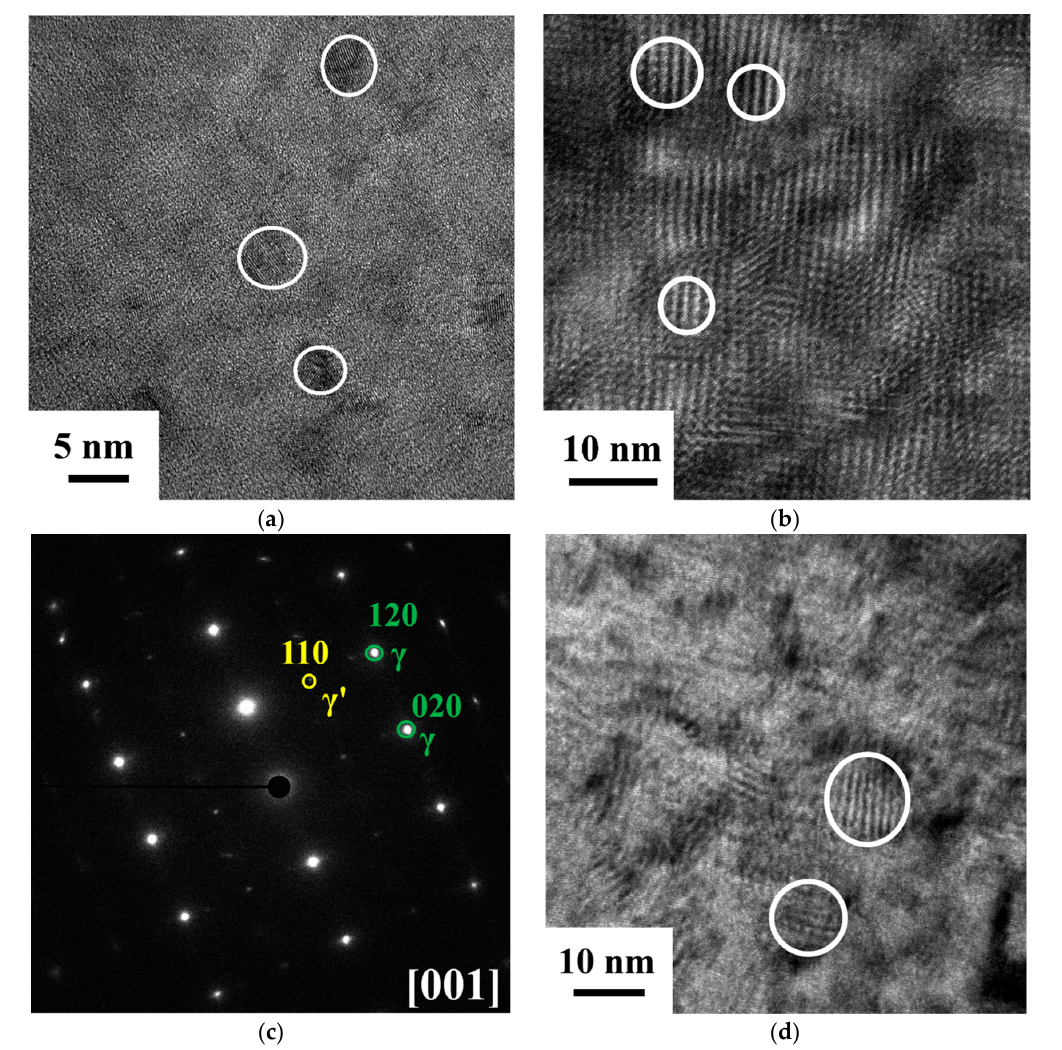
Figure 4. TEM observation of the FeNiCoAlTiNb alloys. ( a ) 600 °C—24 h sample, ( b ) 600 °C—48 h sample ( c ) the corresponding selected-area electron diffraction pattern, and ( d ) 600 °C—72 h